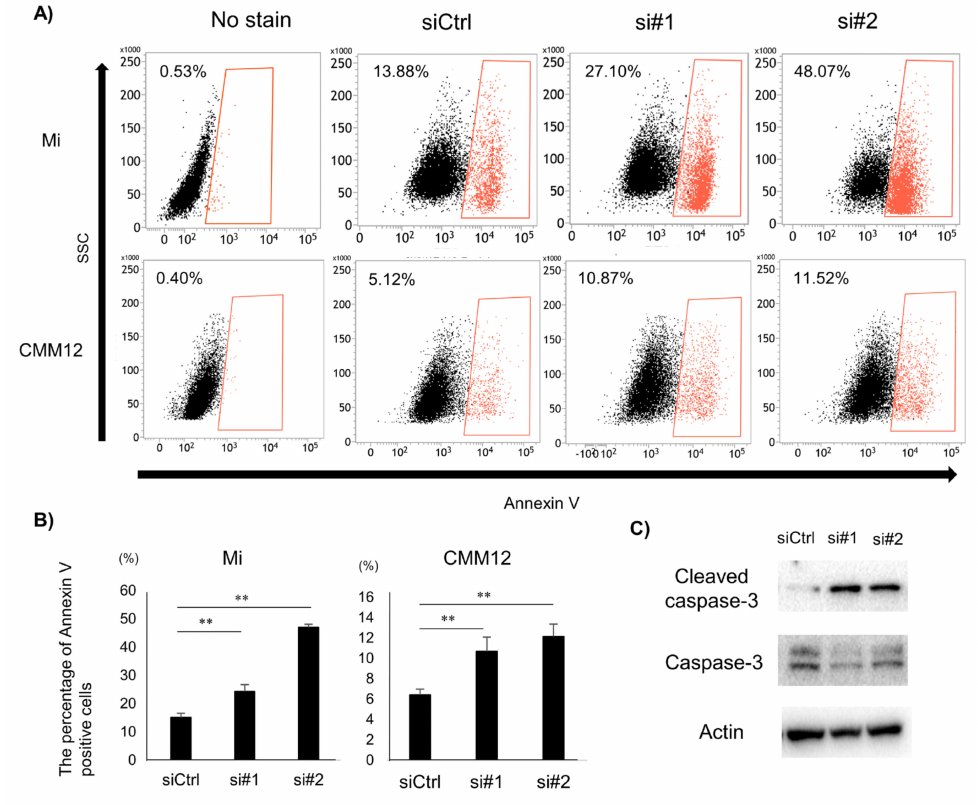
Figure 3. The e ff ect of dPDPN knockdown on induction of apoptosis in canine MM. ( A ) Annexin V-positive cell populations after 48 h siRNA treatment were measured by flow cytometry. Representative images are shown. Non-stained cells were used as a control. ( B ) The percentage of Annexin V-positive cells in control-scrambled siRNA, siRNA#1, or siRNA#2-treated Mi and CMM12 cell lines. This experiment was performed in triplicate. ( C ) Western blot analysis of Cleaved Caspase 3 and Caspase 3 proteins after 48 h siRNA treatment for the Mi cell line. Actin was used as an internal control. **: p < 0.01, siCtrl: Control-scrambled siRNA, si#1: siRNA#1, si#2: